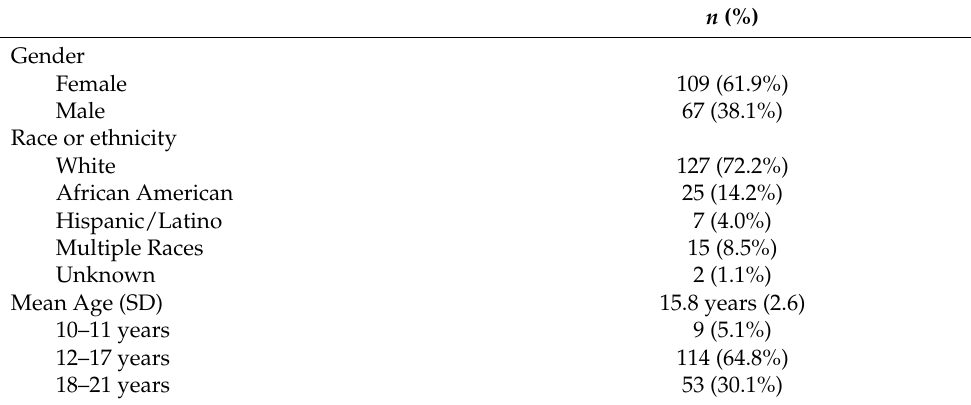
Table 1. Demographics of Study Participants ( n = 176).